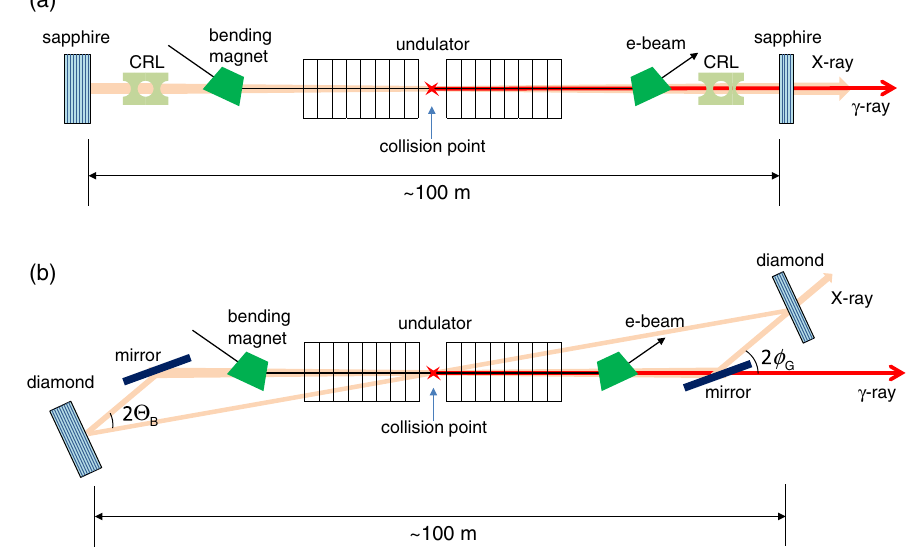
FIG. 1. Schematic views of x-ray FEL oscillators. (a) An oscillator with two normal-incidence sapphire crystals and compound refractive lenses (CRL). (b) An oscillator consisting of two diamond crystals with nonzero Bragg angle, Θ B ≠ 0 and two focusing mirrors with a small grazing angle ϕ G < 1